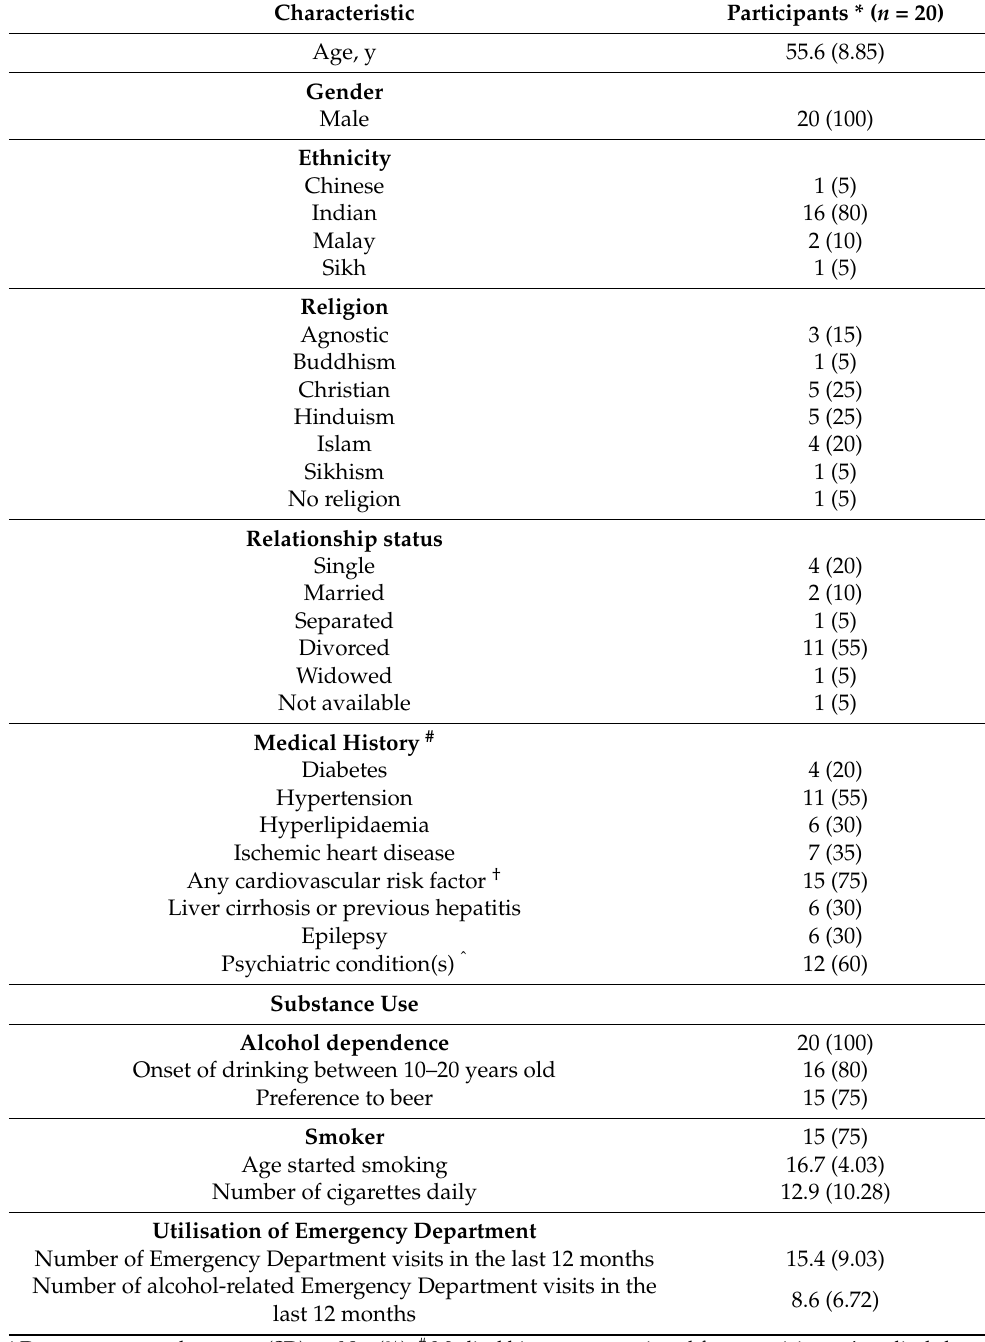
Table 1. Demographic